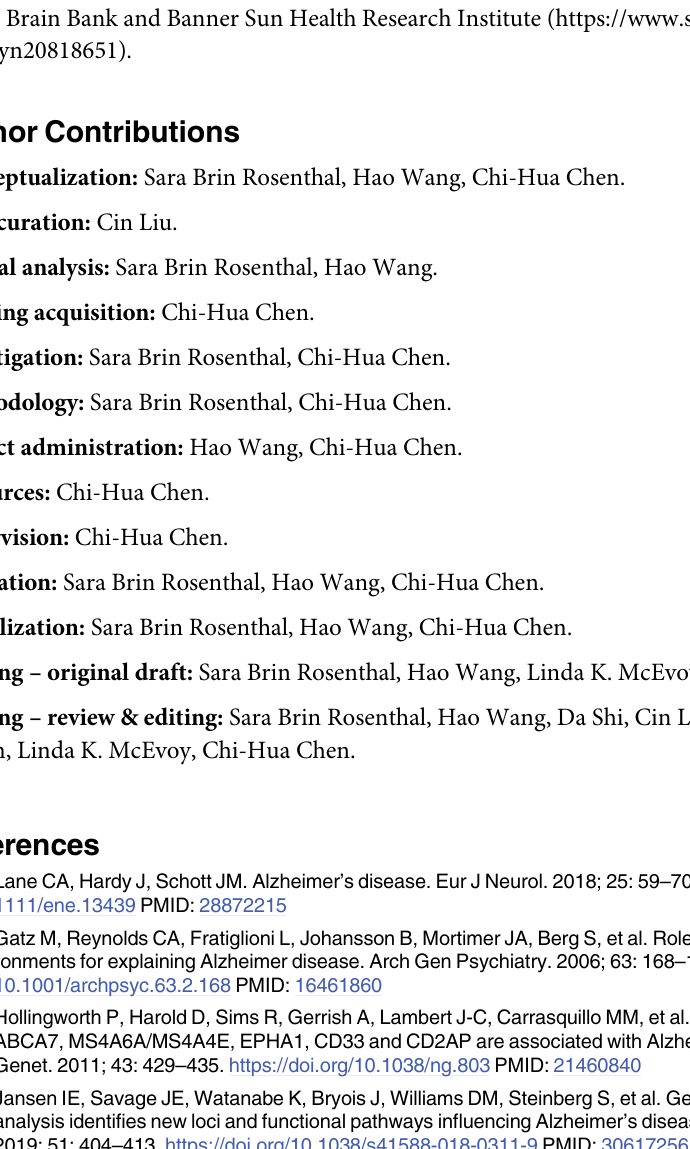
Table B: Functional annotation of the genes in the AD disease module. Table C: Genes in the hierarchical network. Table D: GWAS-identified significant genes that are not in the STRING